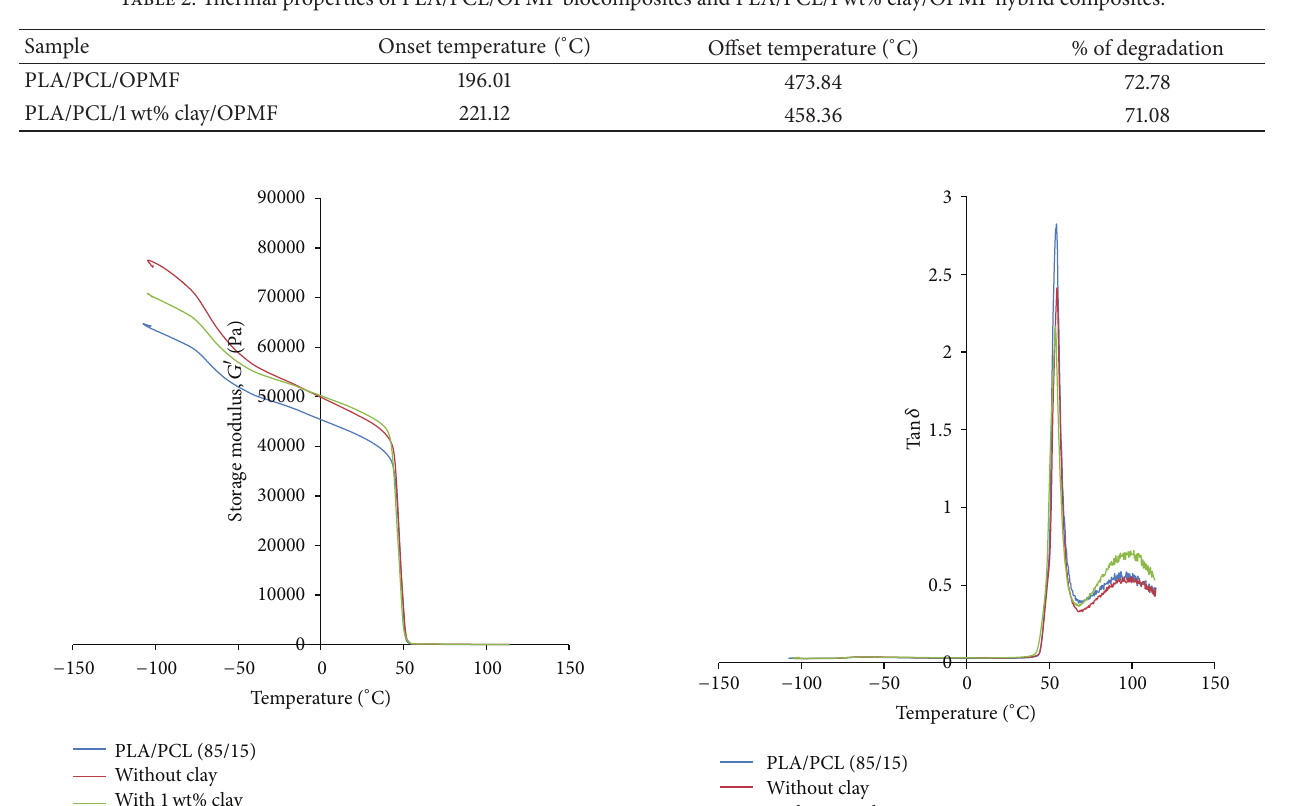
Table 2: Thermal properties of PLA/PCL/OPMF biocomposites and PLA/PCL/1 wt% clay/OPMF hybrid composites.